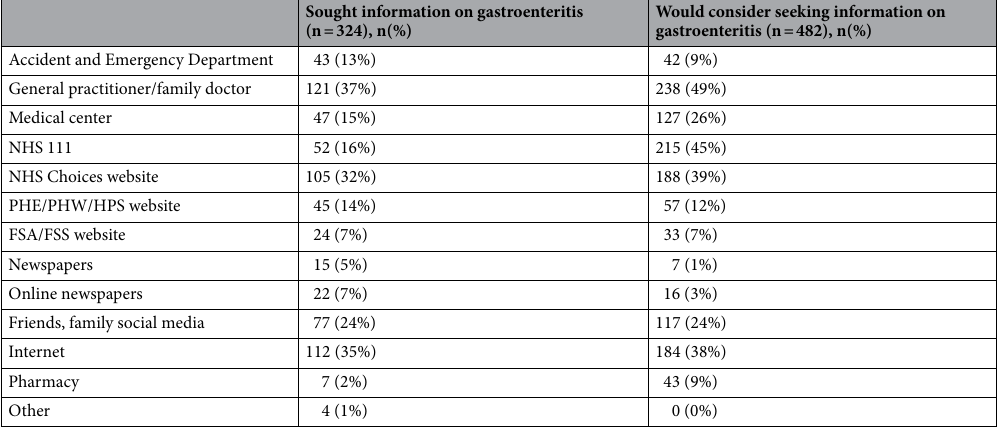
Table 1. Summary on the use of information sources on gastroenteritis. NHS: National Health Service; PHE: Public Health England; PHW: Public Health Wales; HPS: Health Protection Scotland; FSA: Food Standards Agency; FSS: Food Standards Scotland.